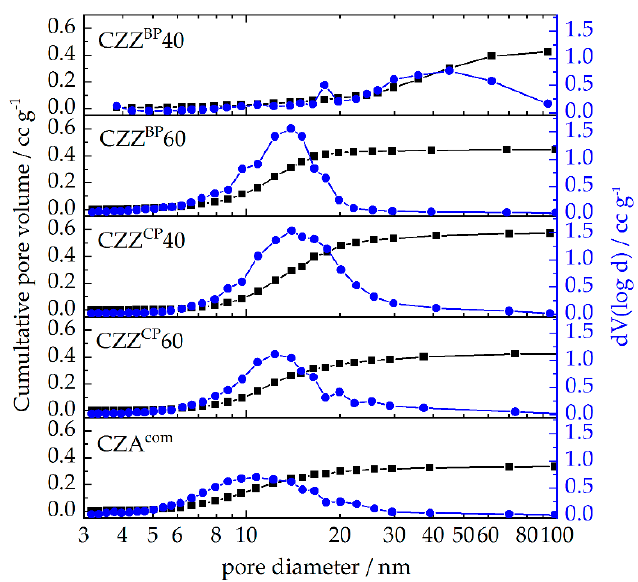
Figure 1. Cumulative pore volume and pore size distribution of the calcined CZZ pre ‐ catalysts and com (N CZA com (N 2 physisorption: 250 g sample, grain size 250–500 μ m, pre ‐ treatment: 12 h at 230 °C). CZA 2 physisorption: 250 g sample, grain size 250–500